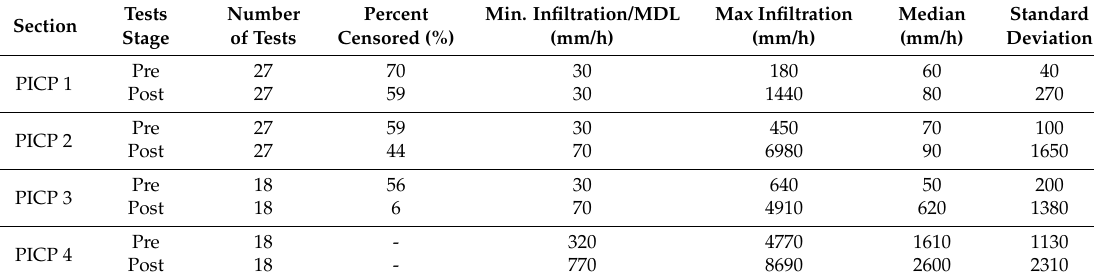
Table 3. Overall Descriptive Statistics.